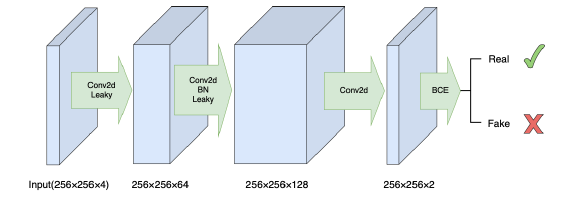
Figure 2. Illustration of Pixel Discriminator. The convolution filters have a size of 1 × 1 and stride of 1. The classification of real and fake is only on pixel level, without any contextual information. The result after binary cross entropy (BCE) is